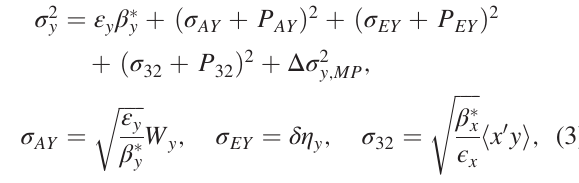
FIG. 5. Dynamic ranges of the IP-BSM at the ATF2 IP. 3 laser crossing modes are